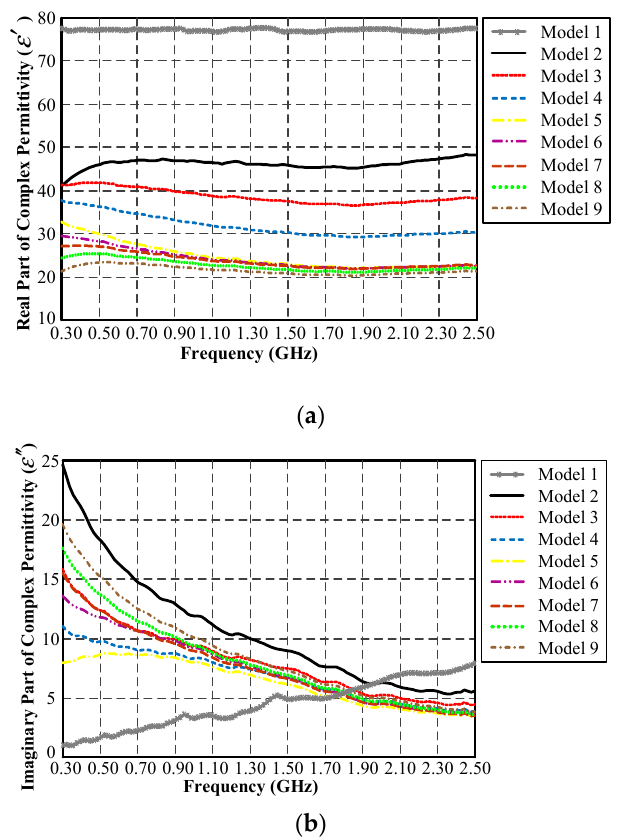
Figure 14. The dielectric constants of nine experimental mixtures of equivalent liquid: ( a ) real part,